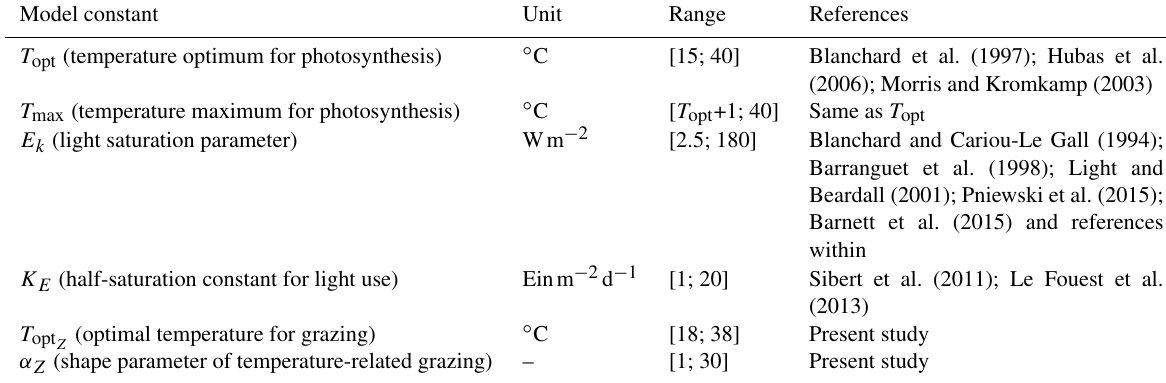
Table 2. Range of values for the random selection of the model constants used in the Monte Carlo sensitivity